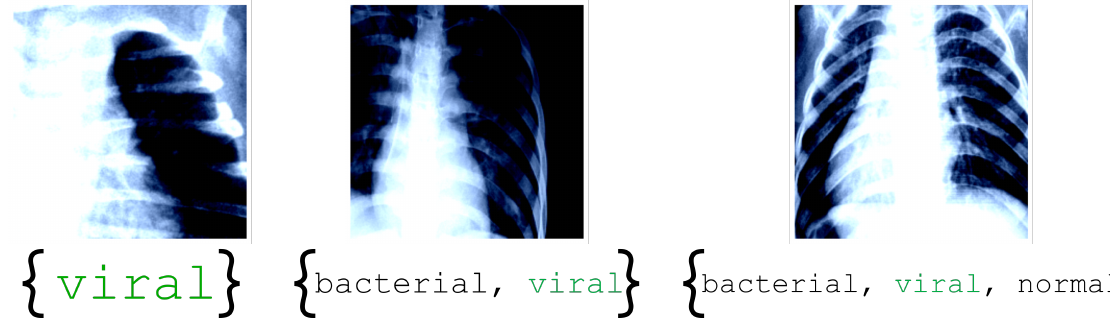
Figure 2: Examples of private conformal prediction sets on COVID-19 data. We show three examples of lung X-rays taken from the CoronaHack data set (Perez et al., 2020) with their corresponding private prediction sets at α = 10% from a ResNet-18. All three patients had viral pneumonia (likely COVID-19). The classes in the prediction sets appear in ranked order according to the softmax score of the model; the center and right images are incorrectly classified if the predictor returns only the most likely class, but are correctly covered by the private prediction sets. See Experiment 4.4 for